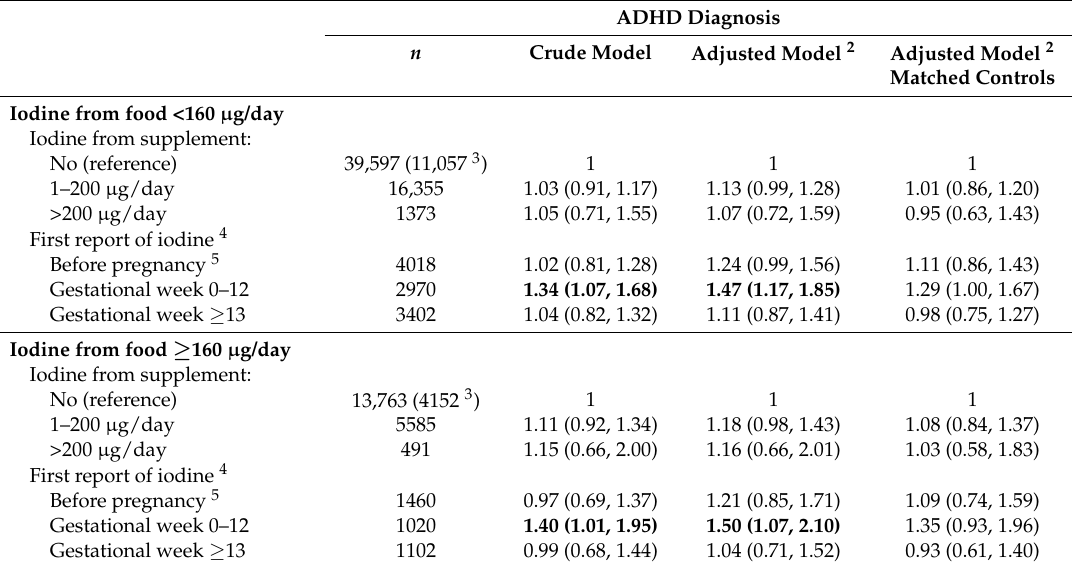
Table 3. Use of iodine-containing supplements in pregnancy and risk of child ADHD diagnosis ( n = 77,164) 1